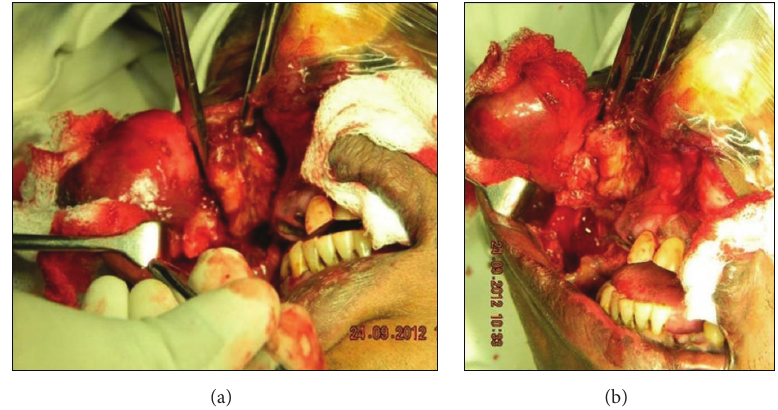
Figure 3: ((a) and (b)) Surgical image showing a capsulated enmasse of lesion which was easily dissected out, devoid of any muscle or bone